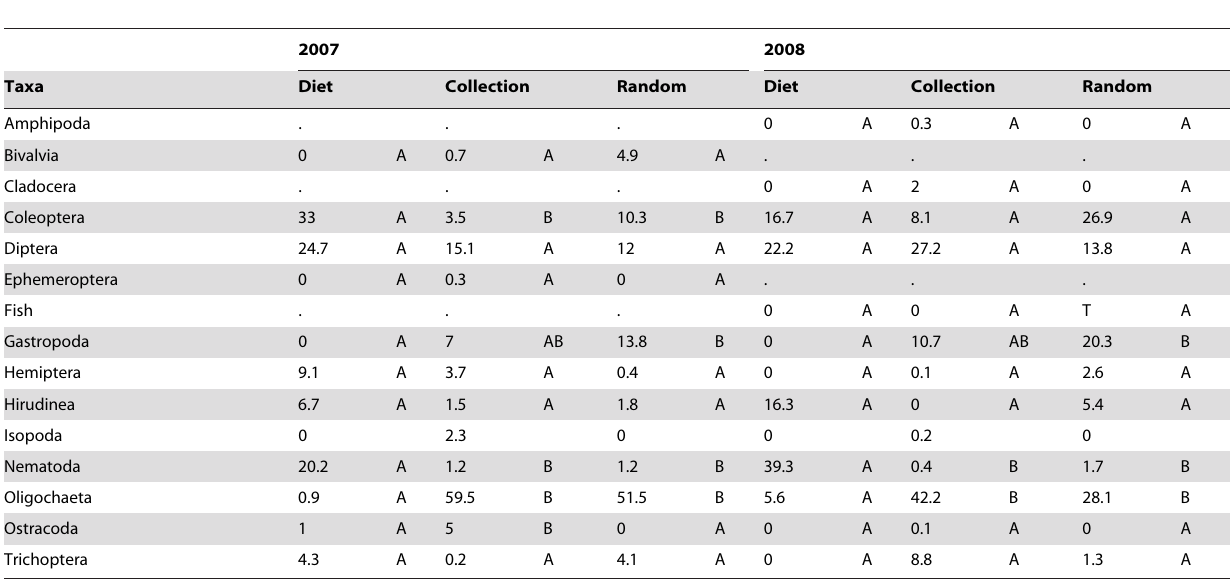
*Values with different letters within rows indicate significant differences of least-squares means (Tukey-Kramer test: P # 0.05) within that year. T indicates a trace amount of material present.